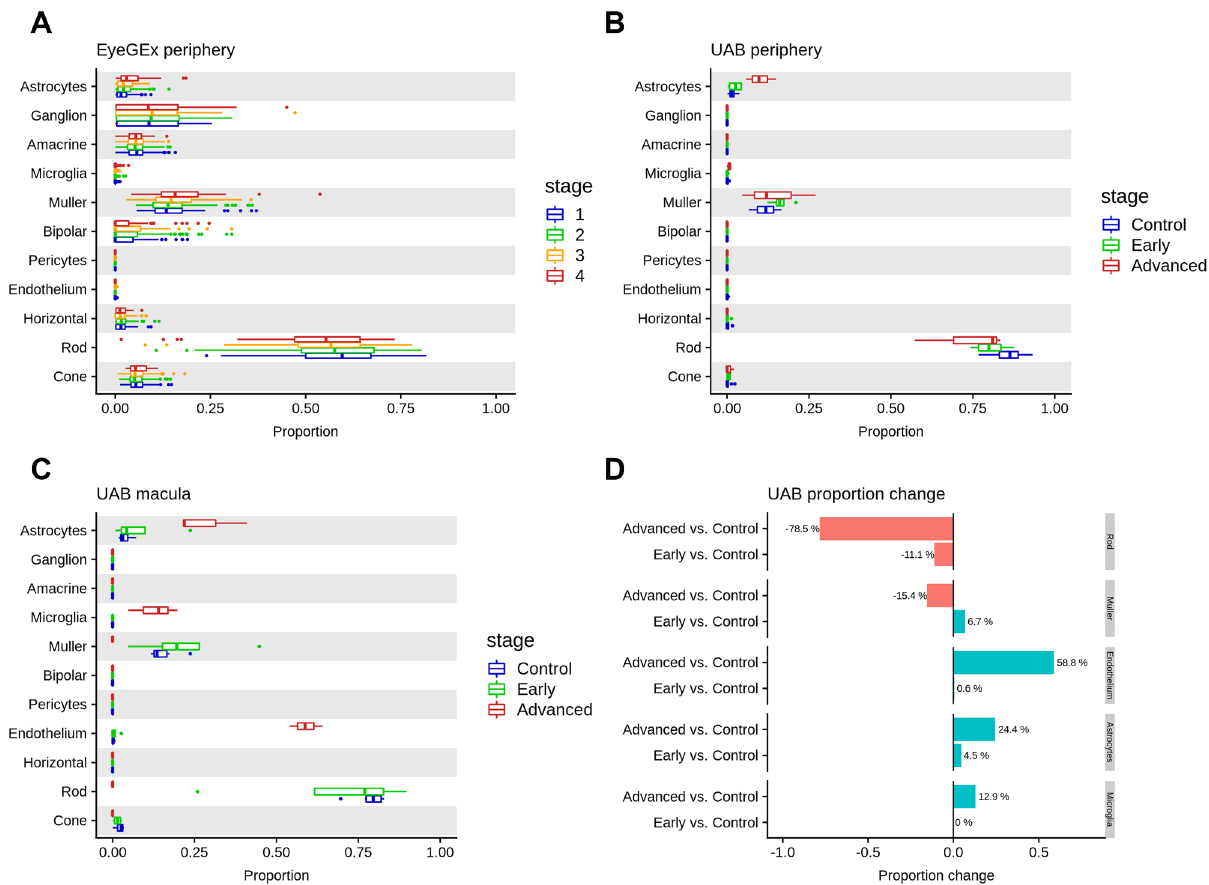
Figure 4. Cell-type deconvolution analysis from bulk RNA-seq data. Cell-type proportions for each bulk RNA-seq sample were estimated using MuSiC with the scRNA-seq data as reference. ( A ) Estimated cell-type proportions for the EyeGEx peripheral retina bulk RNA-samples with four stages of AMD (MGS1: 105; MGS2: 175; MGS3: 112; MGS4: 61). ( B ) Estimated cell-type proportions for the UAB peripheral retina bulk